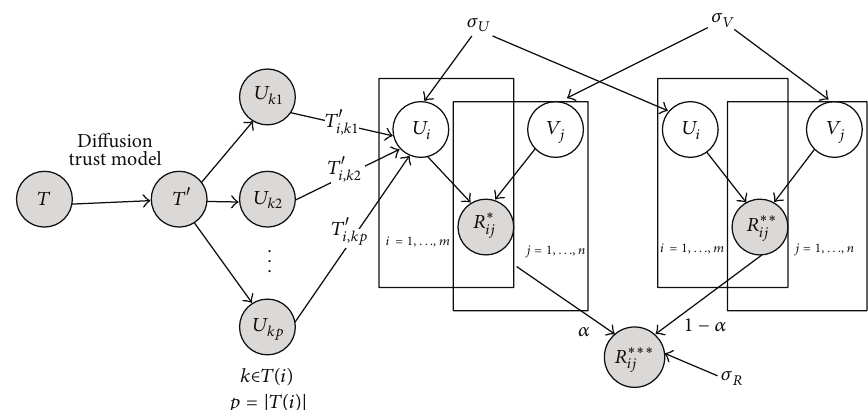
Figure 3: The improved probabilistic factor graph based on trust diffusion